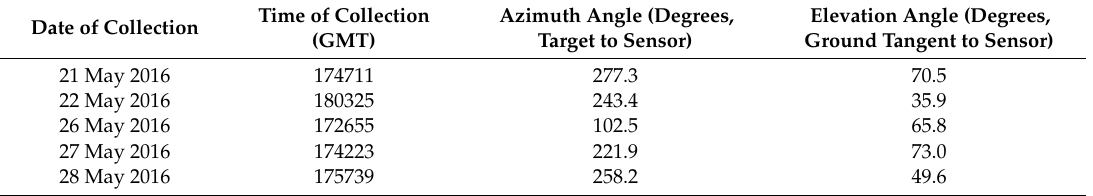
Table 1. WorldView-3 data collection parameters for Southern Great Plains (SGP)